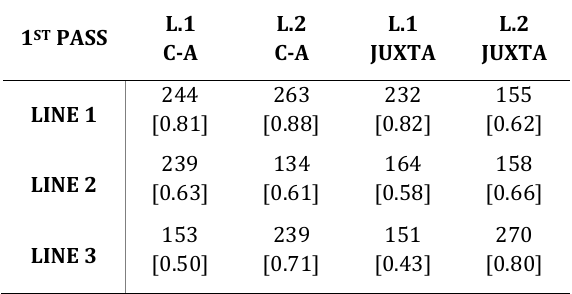
Table 2A. First-pass dwell times (per word) following